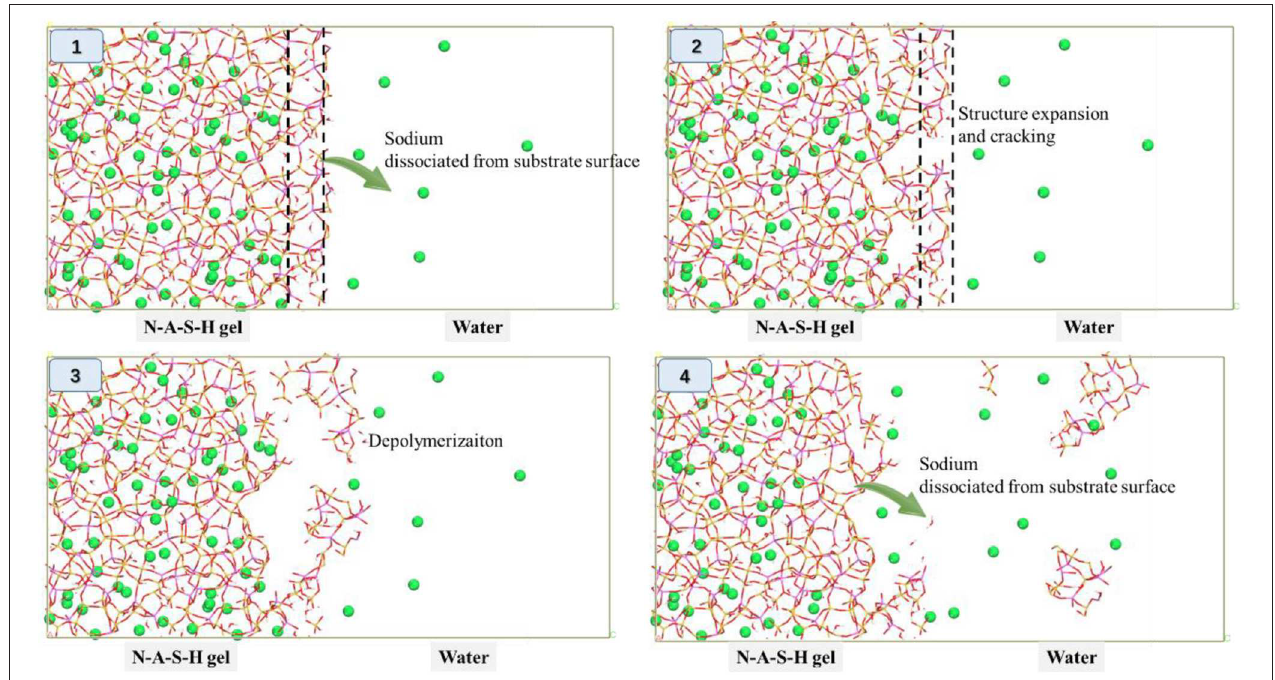
FIGURE 8 | Schematic diagram of leaching process. Green balls stand for